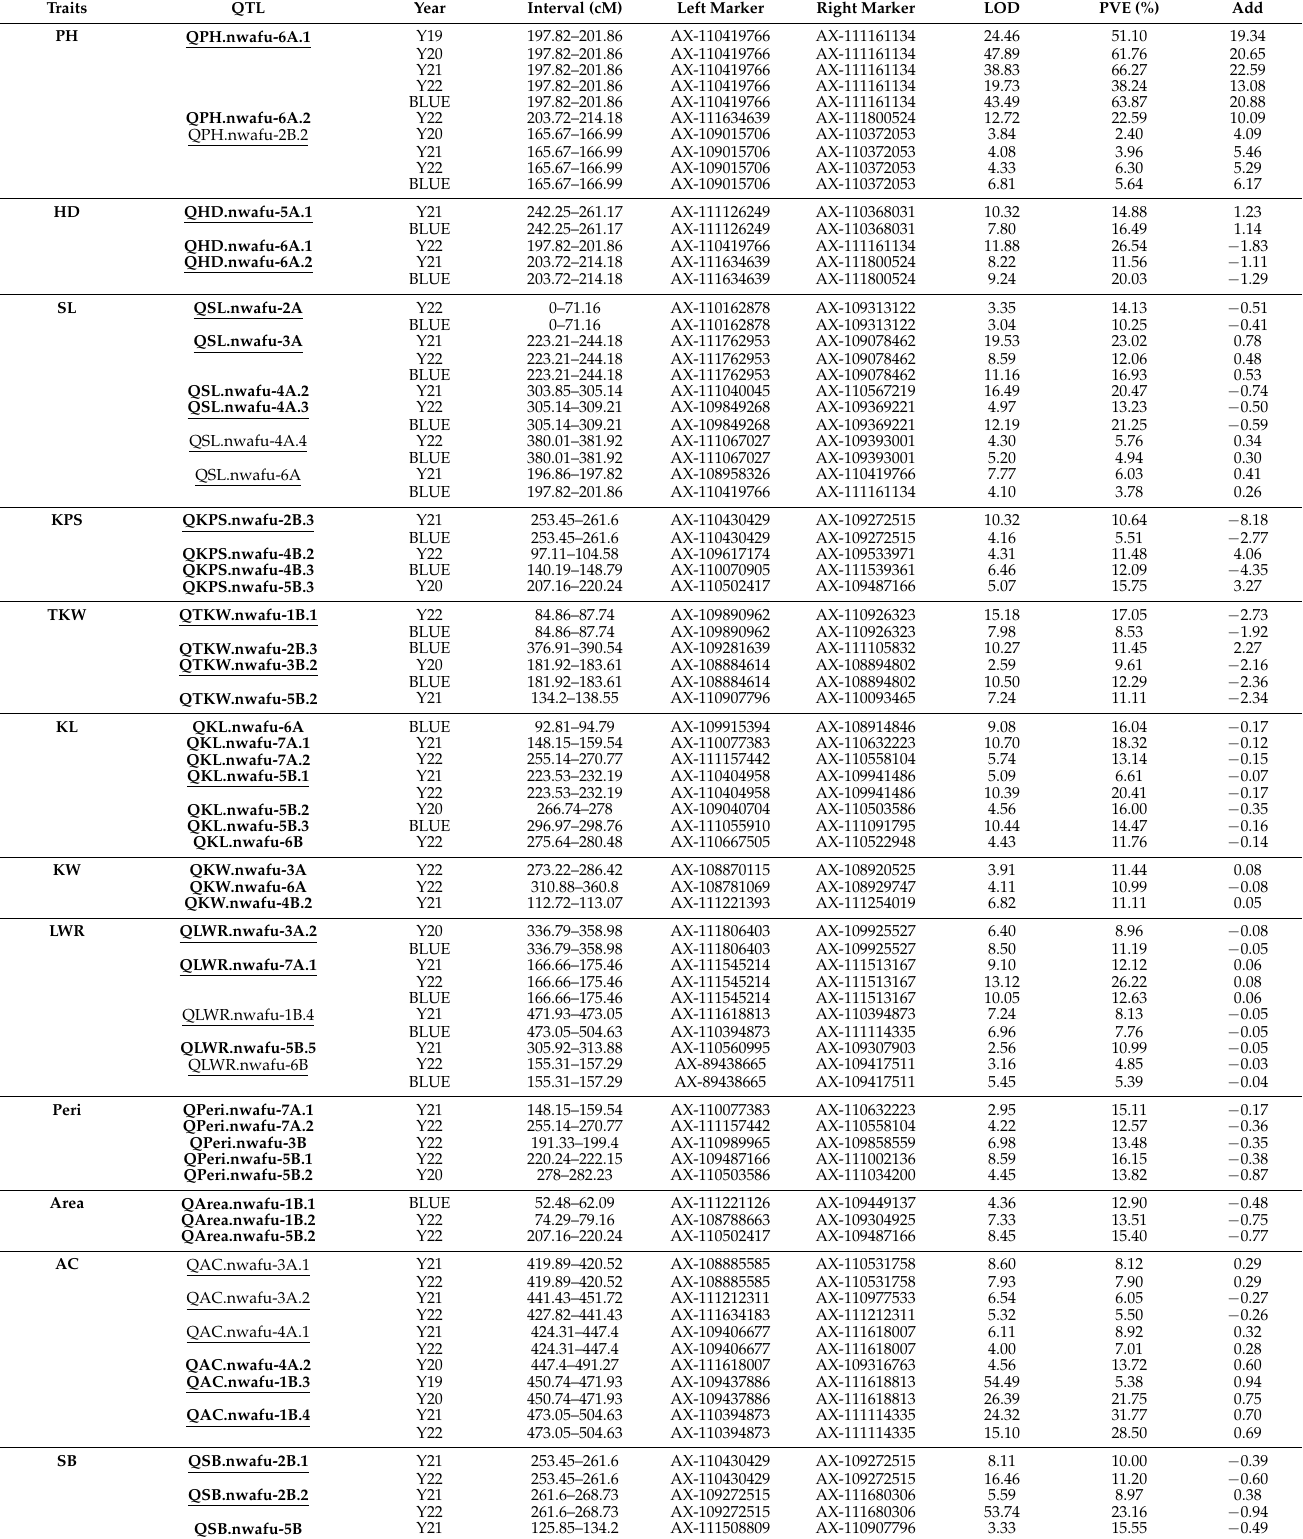
Table 3. Major or stable additive QTLs in this study for the 12 traits in different